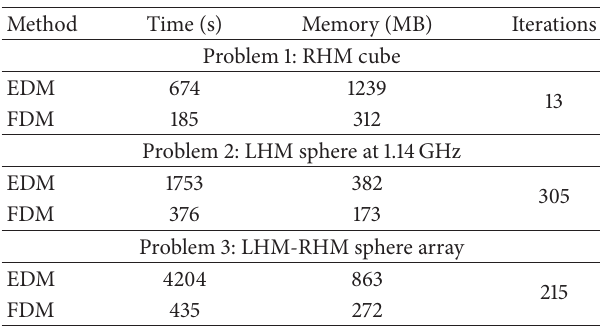
Table 1: Comparison of CPU time, memory cost, and iterations of RCS solutions for EDM and